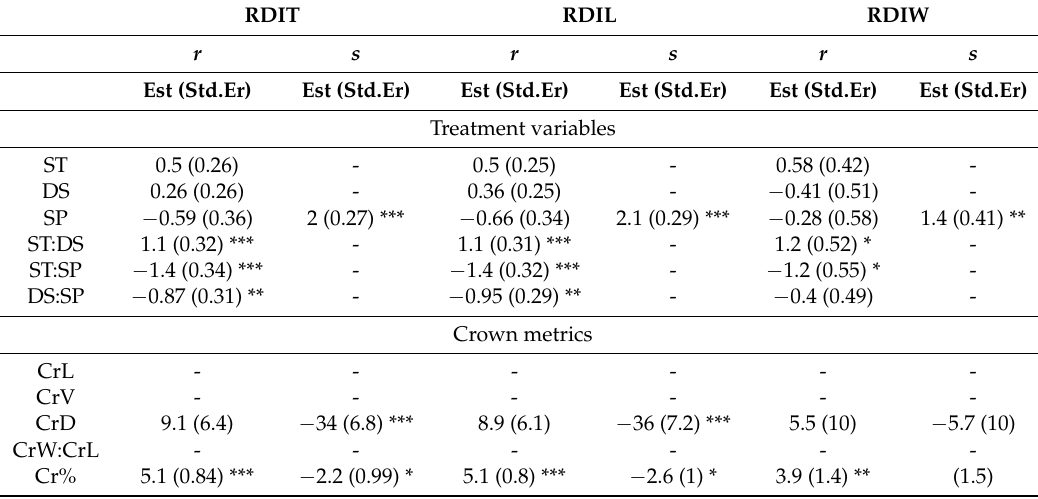
Table 4. Estimates and standard error for the best models to predict r and s beta distributions parameters (Equation (6)). AIC criteria were used to select each best model among